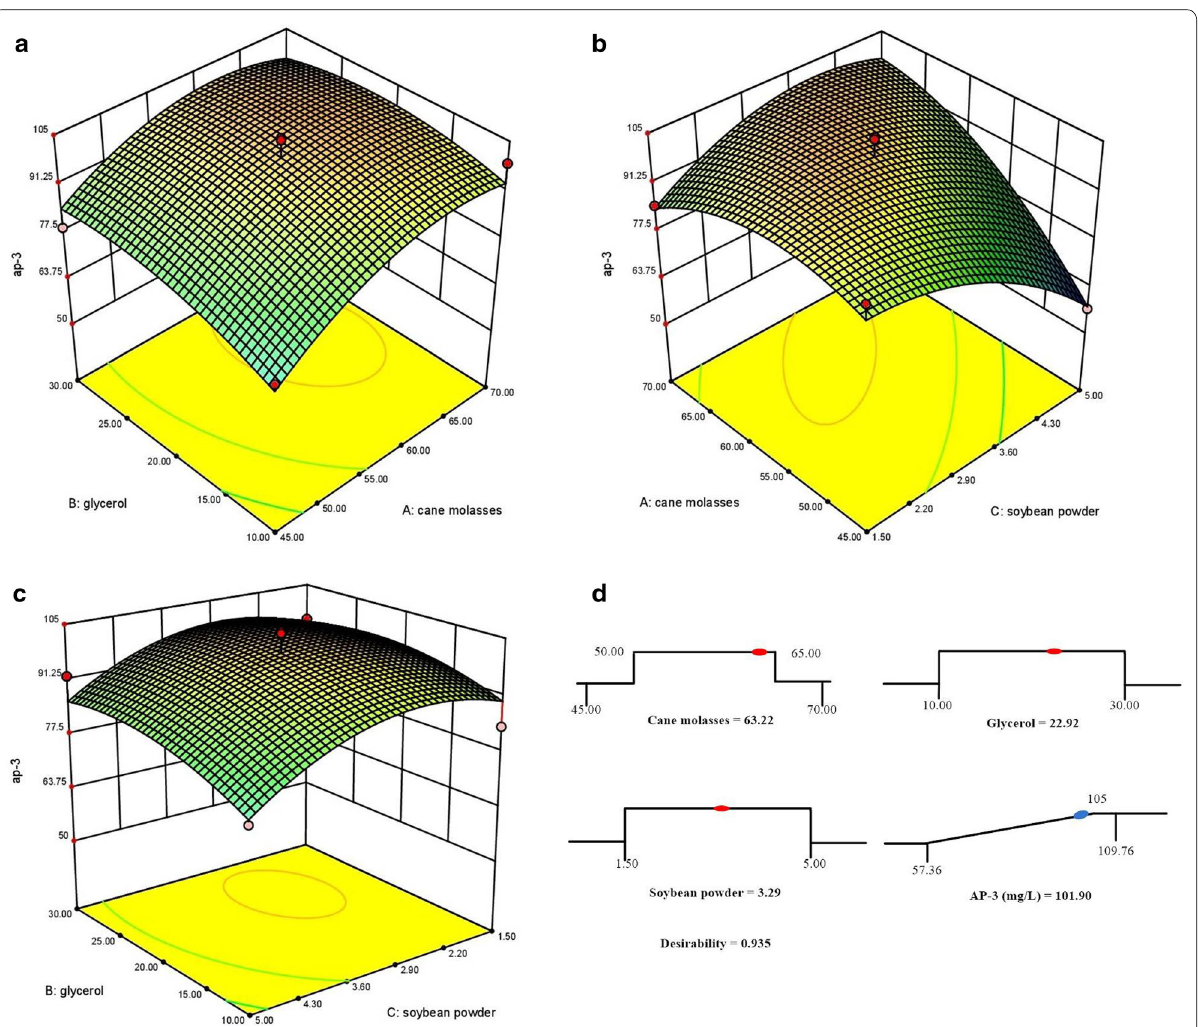
Fig. 2 Response surface and contour plot of AP‑3 production. a Effects of glycerol and cane molasses; b effects of glycerol and soybean powder; c effects of cane molasses and soybean powder; d ramps view of numerical optimization. The optimal factor settings were shown with red points and the optimal response prediction value was displayed in